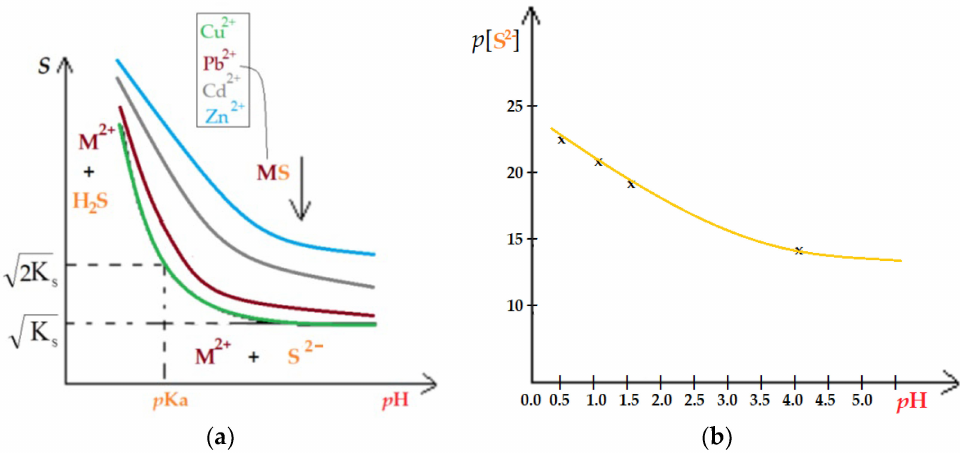
Figure 15. Diagrams of the sulfide metals solubility ( S ) vs. pH ( a ); and pS 2 − vs. pH (within the range of interest) ( b